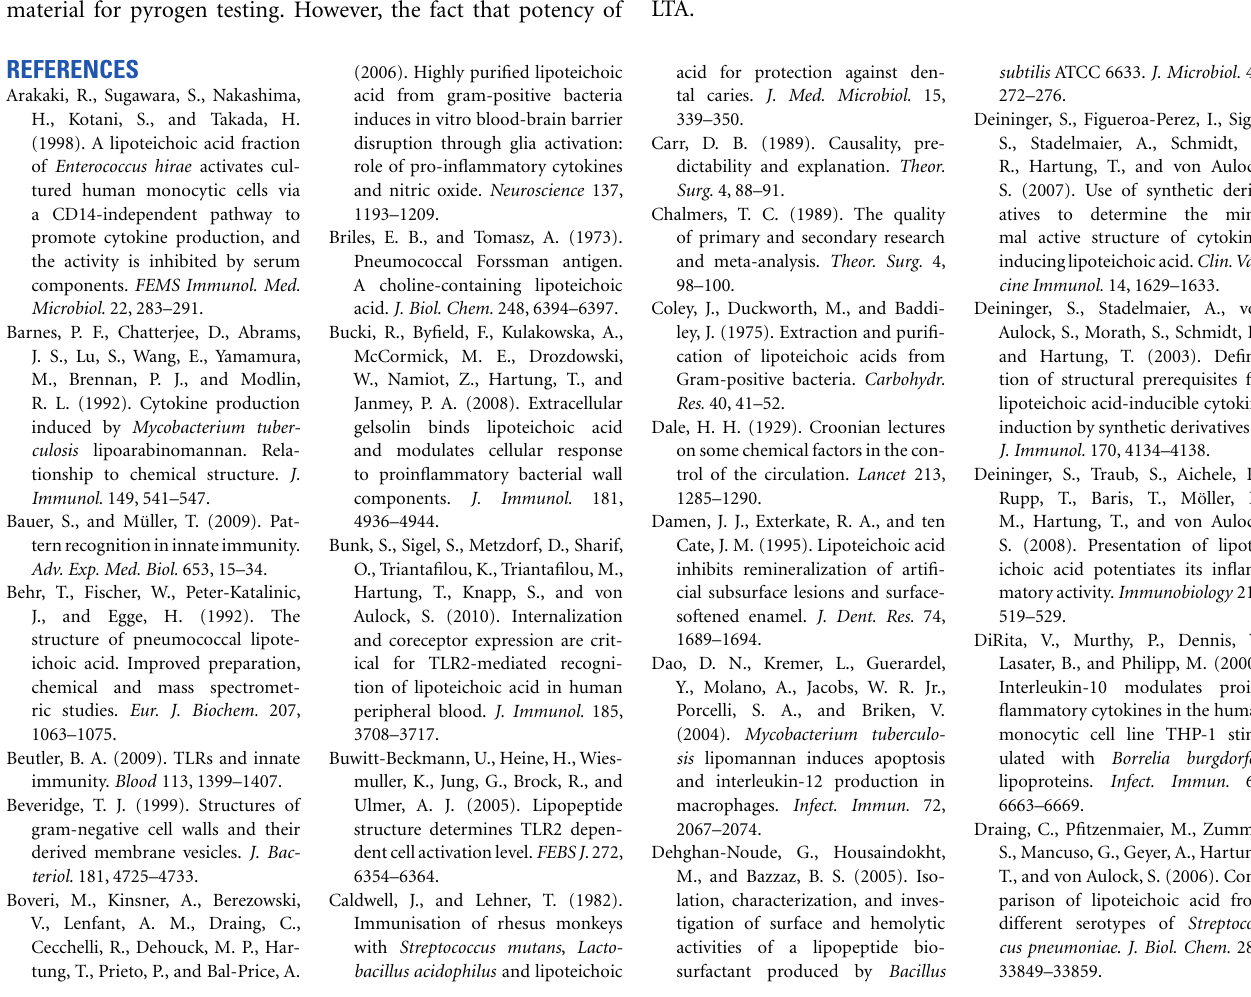
+ ++ − − Experiment +++ − ++ LTA as monocyte activator is only fully exerted, i.e., amplified by about 4 log orders (Deininger et al., 2008) when presented on a surface, requires either the use of very high concentrations of pure LTA or reliance on crude membrane preparations that present LTA appropriately. Future developments might include the coating of (nano-)particles with LTA to establish a pure highly active Gram- positive reference material. For current validation efforts, the use of bacterial lysates appears to be advisable, which also safeguards the presence of possible pyrogenic response modifiers other than